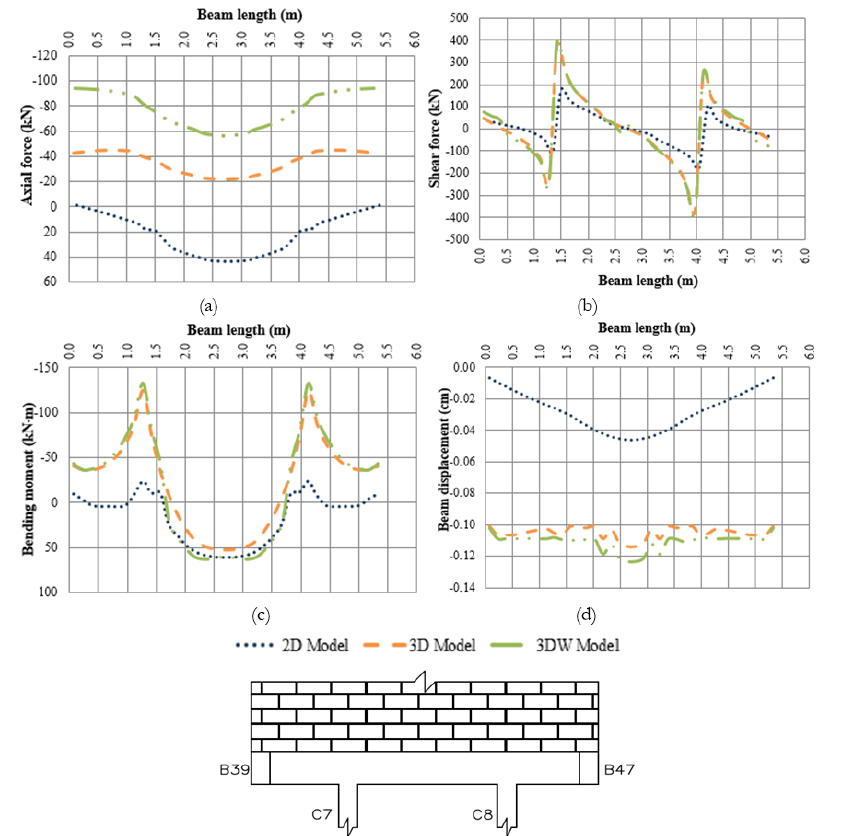
Figure 13. Forces on the support beam of Wall 3: (a) Axial force; (b) Shear force; (c) Bending moment; (d) Vertical